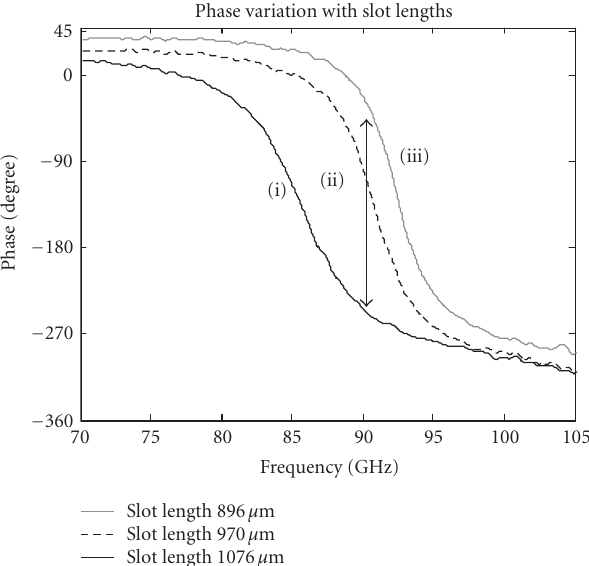
Figure 3: Measured phase versus frequency curves, slot lengths as variable parameter. (Slot length of curve (i) 1076 μ m, curve (ii) 970 μ m, and curve (iii) 896 μ